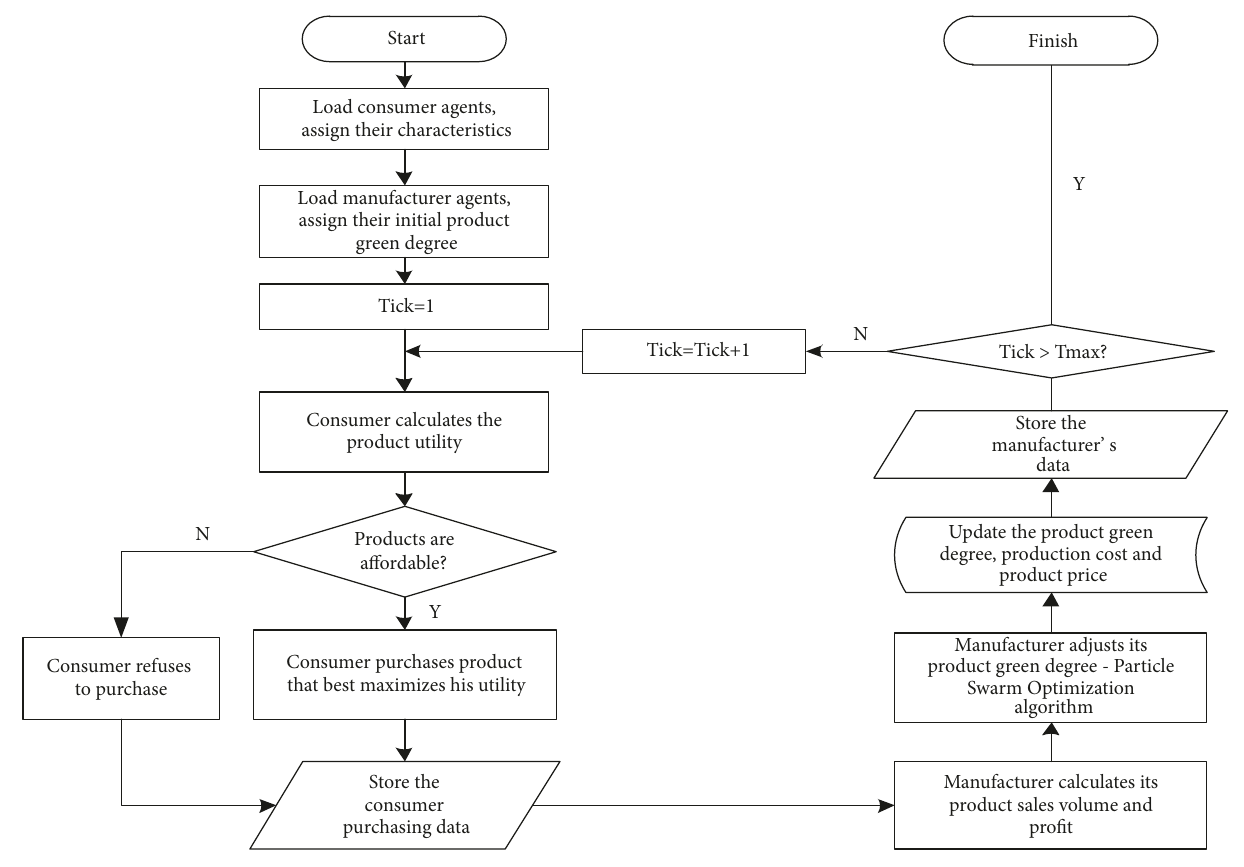
Figure 2: Agent interaction flow chart.